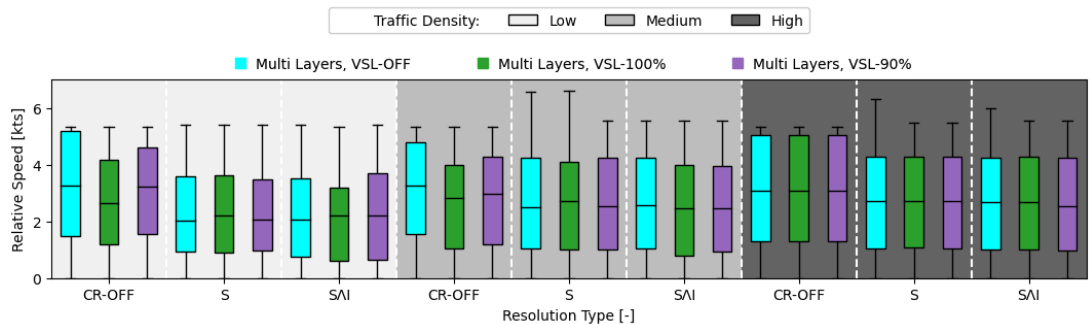
Figure 21. Relative speed between pairs of aircraft during losses of separation with multiple